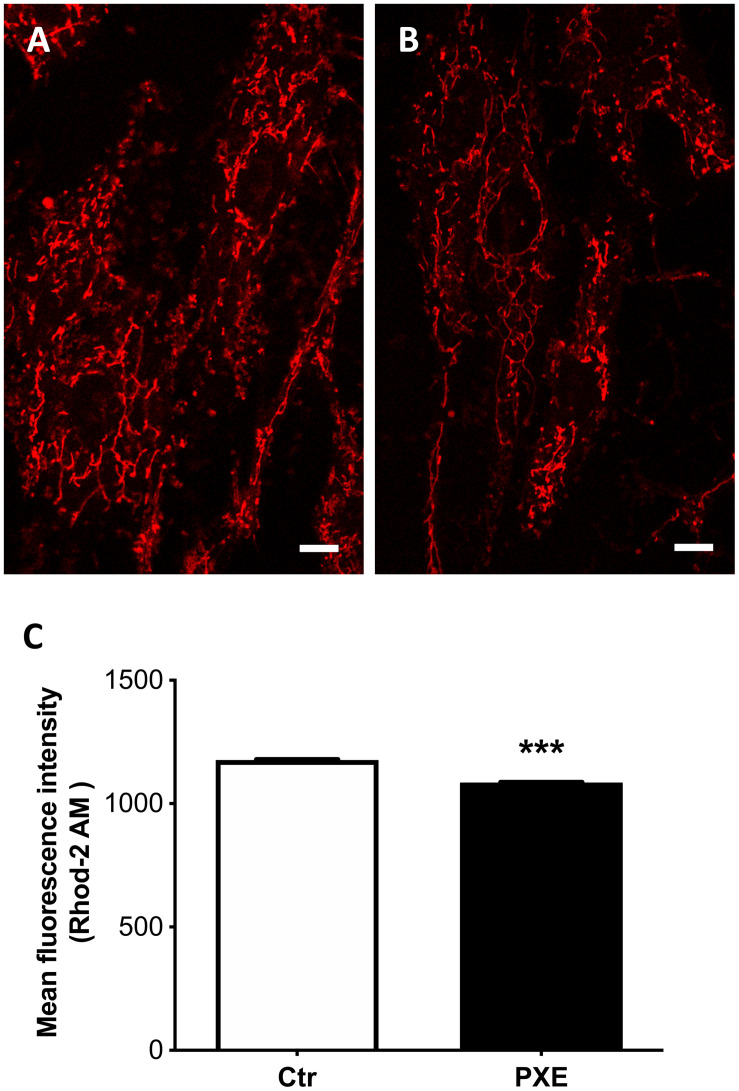
Representative images of mitochondrial free calcium in control (Ctr) (A) and in Pseudoxanthoma elasticum (PXE) fibroblasts (B). Cells were loaded with Rhod-2 AM to determine mitochondrial calcium levels and observed by confocal microscopy in a live-imaging mode. Bar = 10 μm. (C) Quantification of mitochondrial free calcium levels expressed as mean fluorescence intensity in control and in PXE. Data are represented as mean ± SEM of three independent experiments conducted in triplicate on each cell line. ***p < 0.001 PXE vs Ctr.